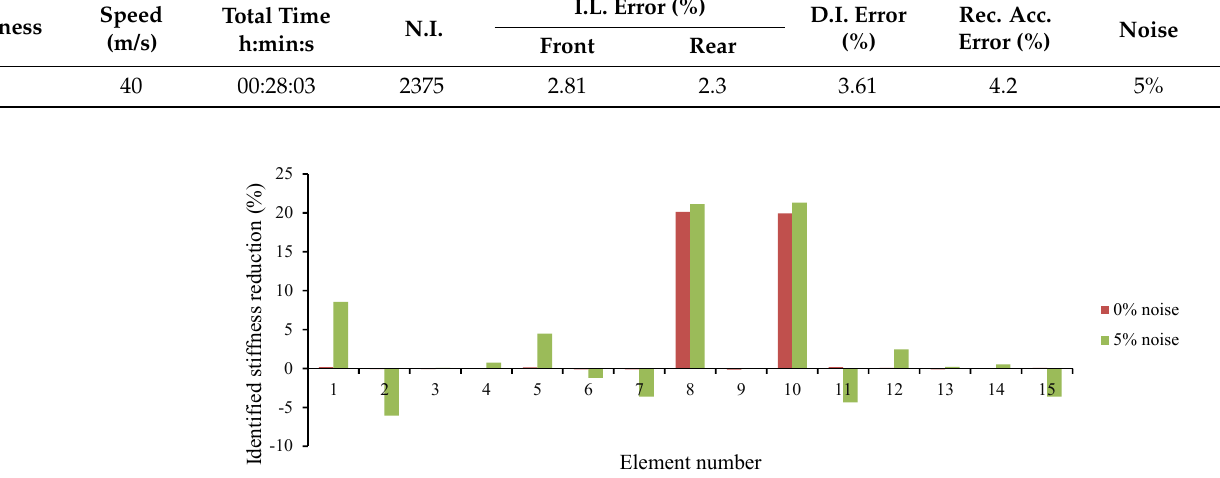
Figure 10. Effect of noise on damage identification of a two-span continuous bridge.